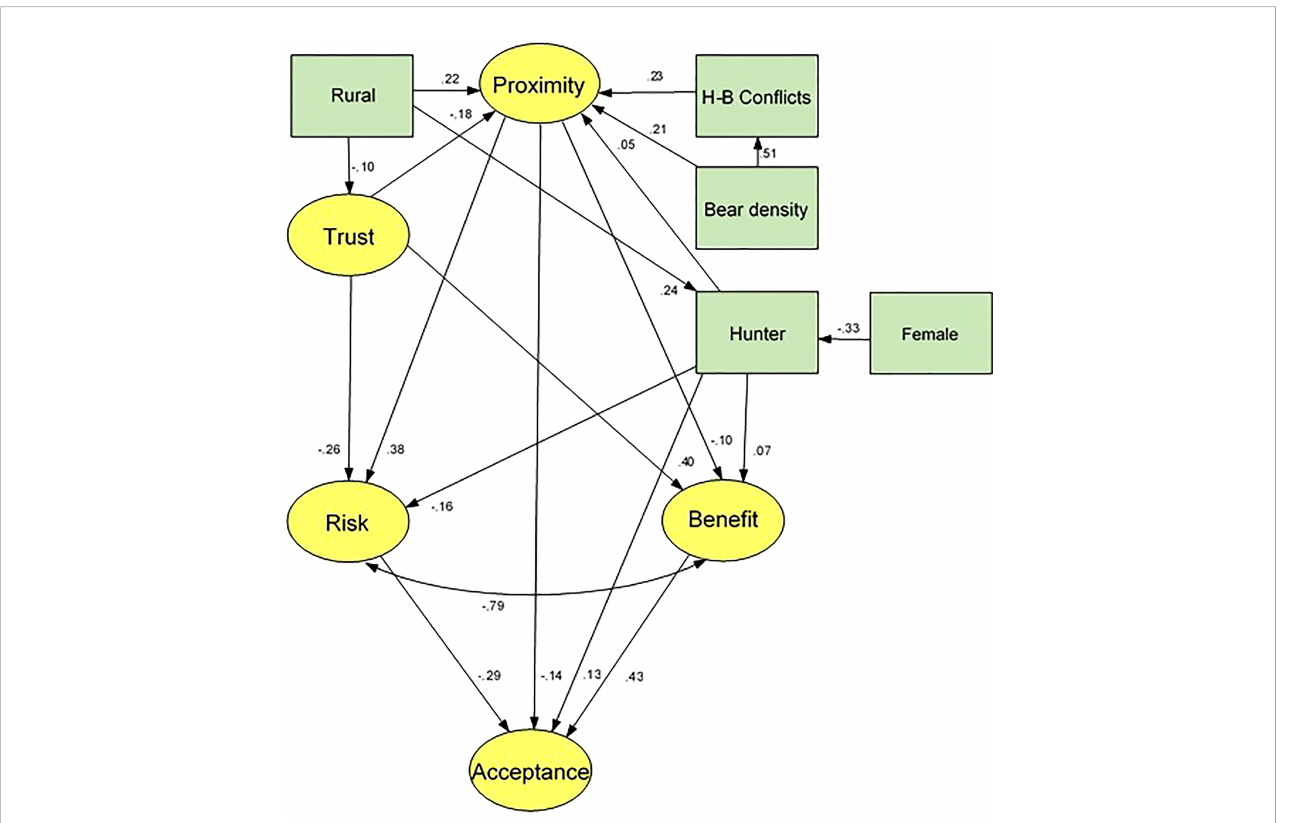
FIGURE 6 Standardized coef fi cients for best fi t model of the ecological, social, and psychological variables that in fl uence acceptance capacity for black bears ( Ursus americanus) . Rectangles represent measured variables. Ovals represent latent variables. Straight lines represent hypothesized paths between variables. Curved lines represent covariance between